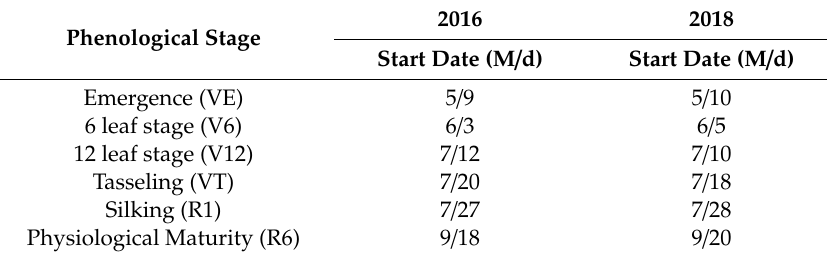
Table 3. Phenology of spring maize in 2016 and